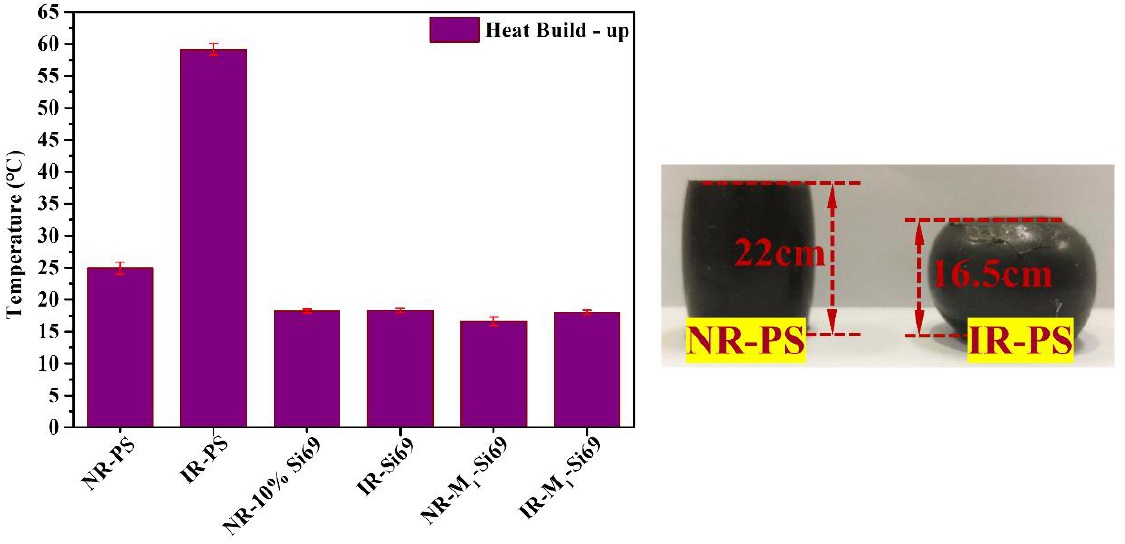
Figure 11. Heat build-up of the silica/rubber nanocomposites.